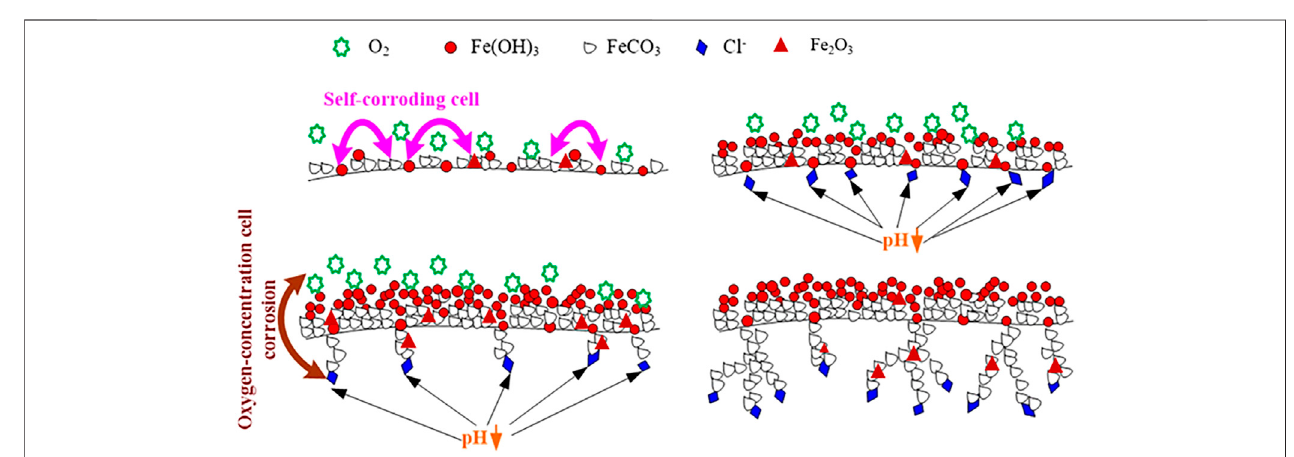
FIGURE 11 | Schematic of the formation of fi lm on N80 steel in an aqueous environment containing CO 2 and O 2 .